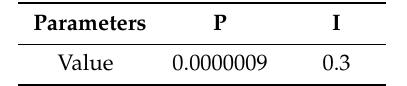
Table 3. Parameters used for the signal generator reference.